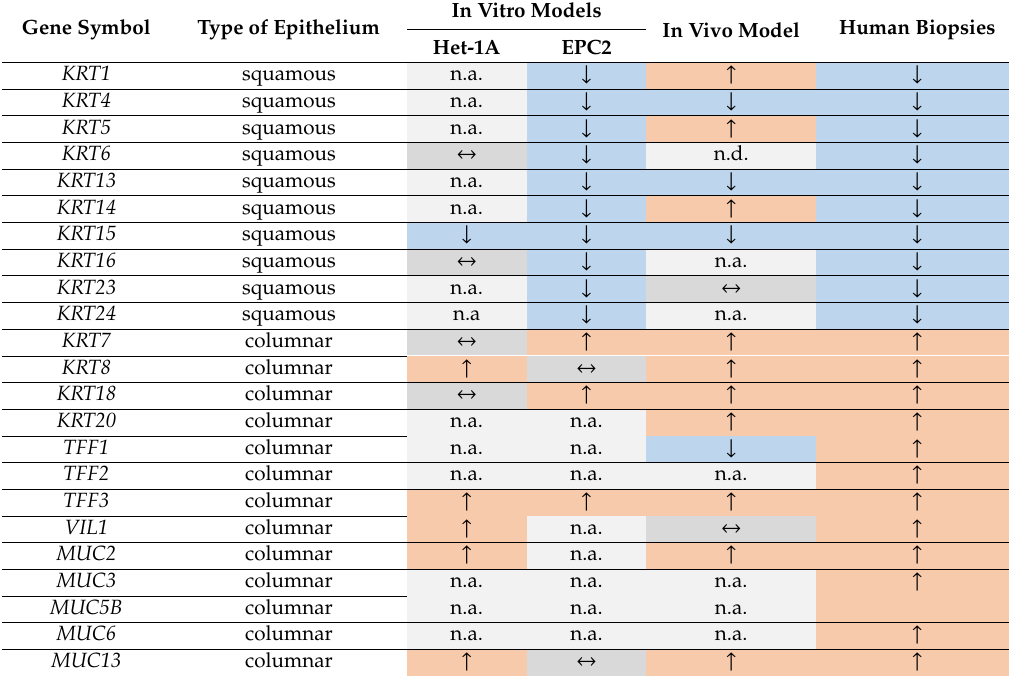
Table 5. Summary of alterations in expression of squamous and columnar epithelium-specific genes observed in human biopsies and in vitro using Het-1A and EPC2 cells and in vivo EGDA rat model. A vertical up arrow ( ↑ ) indicates upregulation of mRNA expression in Barrett’s metaplasia as compared with samples without Barrett’s metaplasia / untreated control cells / intact rats (background in orange); a vertical down arrow ( ↓ ) indicates downregulation of mRNA expression in Barrett’s metaplasia as compared with samples without Barrett’s metaplasia / untreated control cells / intact rats (background in blue); a horizontal left right arrow ( ↔ ) indicates no changes in mRNA expression (background in dark grey); n.a. indicates no amplification; n.d. not determined (background in light